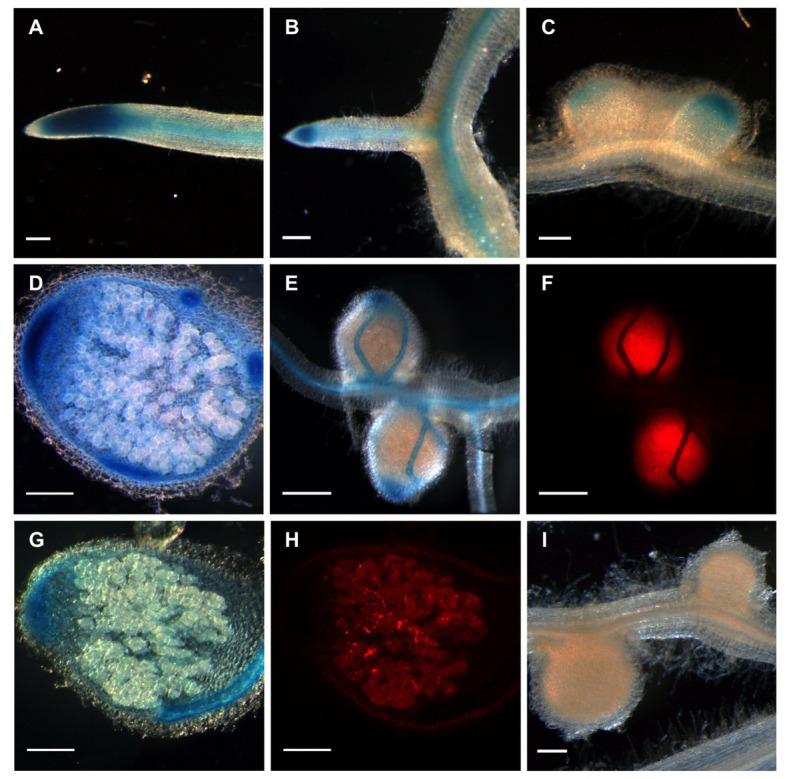
Localization of MtGlb1-2 promoter activity gene in Medicago truncatula roots and nodules. The promoter region was cloned into the binary vector pBGWFS7 (Karimi et al., 2002) to make promoter: GUS fusions. Roots expressing the construct were produced by hairy root transformation and plants were inoculated with Sinorhizobium meliloti expressing DsRed. (A,B) GUS activity is observed in the apex and vascular bundles of the primary root and a lateral root. (C) In young nodules, about 2 weeks post-inoculation (wpi), expression is readily visible also in the apex, encompassing zones I and II. (D,E,G). At later stages (4 wpi), expression is readily visible also in the vascular bundles. In (F) and (H), GUS activity does not appear to co-localize with infected cells. (I) Nodulated roots (2 wpi) corresponding to plants transformed with the empty vector pBGWFS7 as a negative control. Images (A–E,G,I) were taken with transmitted light. Images (F) and (H) correspond to nodules shown in (E) and (G), respectively, and were taken with a DSR filter (Leica). Scale bars, 200 μm.